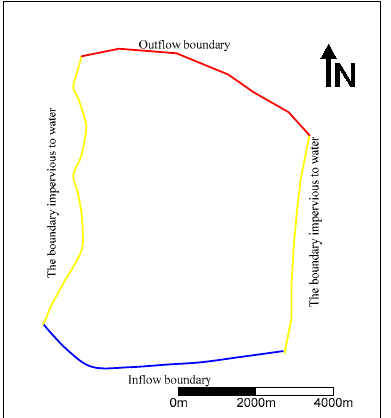
Figure 3. Generalization of the boundary conditions.